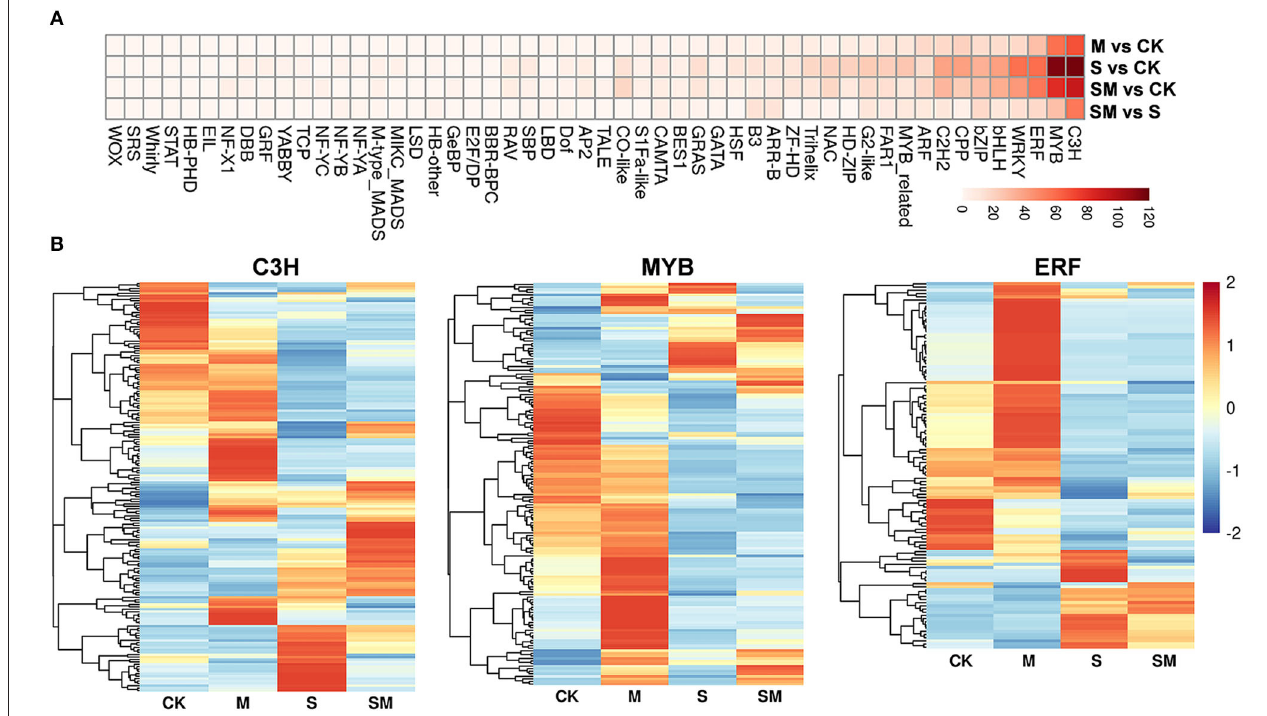
FIGURE 7 | Expression analysis of TF families in different comparisons. (A) Heatmap analysis of TF families. (B) The differential expression pattern of MYB, NAC, and WRKY families.